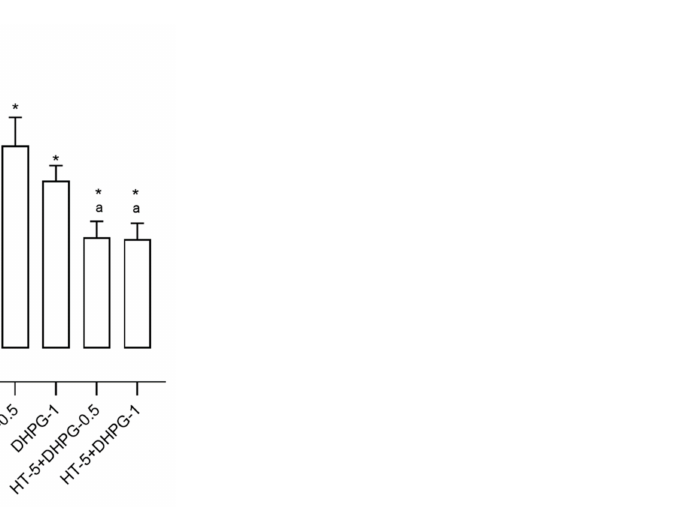
Figure 1. Lactate dehydrogenase efflux (LDH) after the reoxygenation period in brain slices of healthy rats (NDR); two-month follow-up diabetic rats (DR); and DR treated with hydroxytyrosol 5 mg/kg/day (HT-5), 3,4-dihydroxyphenyglycol 0.5 or 1 mg/kg/day (DHPG-0.5 or DHPG-1), HT-5 plus DHPG-0.5 or DHPG-1, p.o. for two months. n = 10 rats per group. + p < 0.05 with respect to NDR. * p < 0.05 with respect to DR. a p < 0.05 with respect to DHPG-0.5, DHPG-1, and HT-5. Table 2. Oxidative and nitrosative stress parameters (mean ± standard deviation) in brain slices after the hypoxia–reoxygenation period of healthy rats (NDR); diabetic rats (DR); and DR treated with hydroxytyrosol 5 mg/kg/day p.o. (HT-5), 3 (cid:48) ,4 (cid:48) -dihidroxifenilglicol 0.5, or 1 mg/kg/day p.o. (DHPG-0.5, DHPG-1) or their associations. n = 10 rats per